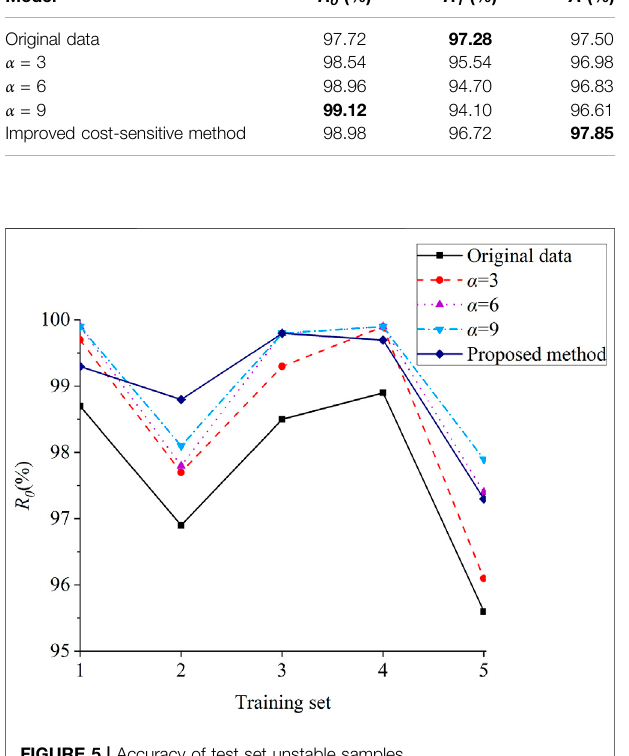
FIGURE 5 | Accuracy of test set unstable samples.